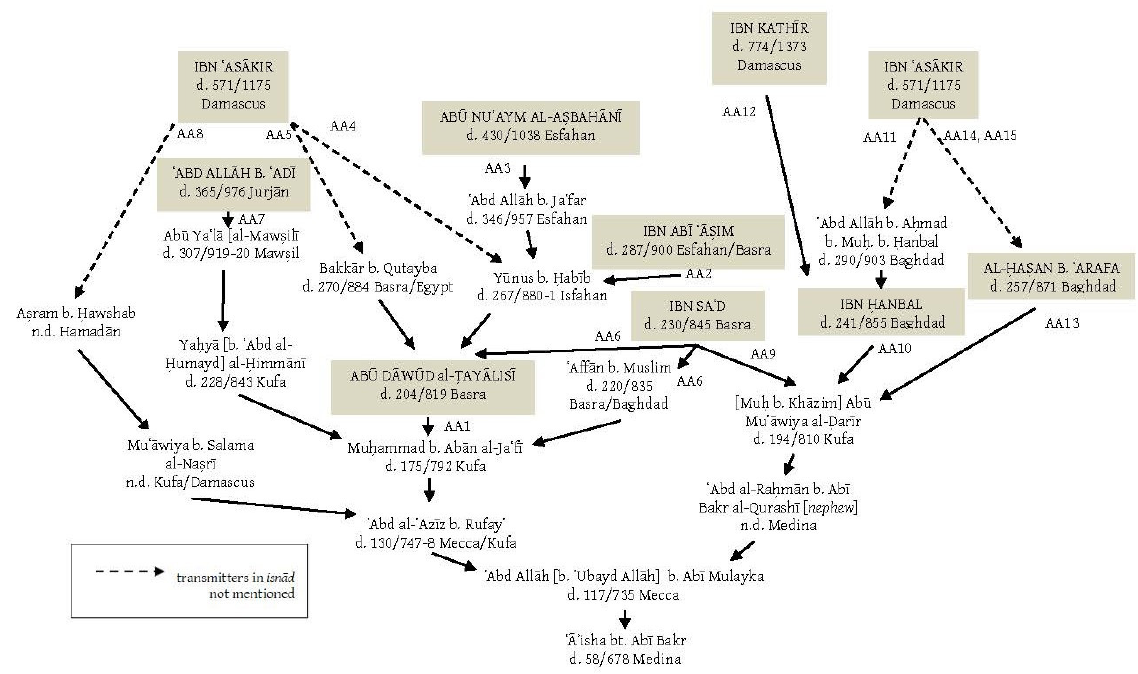
Figure 6. The isn ā d bundle of Ibn Ab ī Mulayka’s traditions from ʿ Ā ʾ isha bt. Ab ī